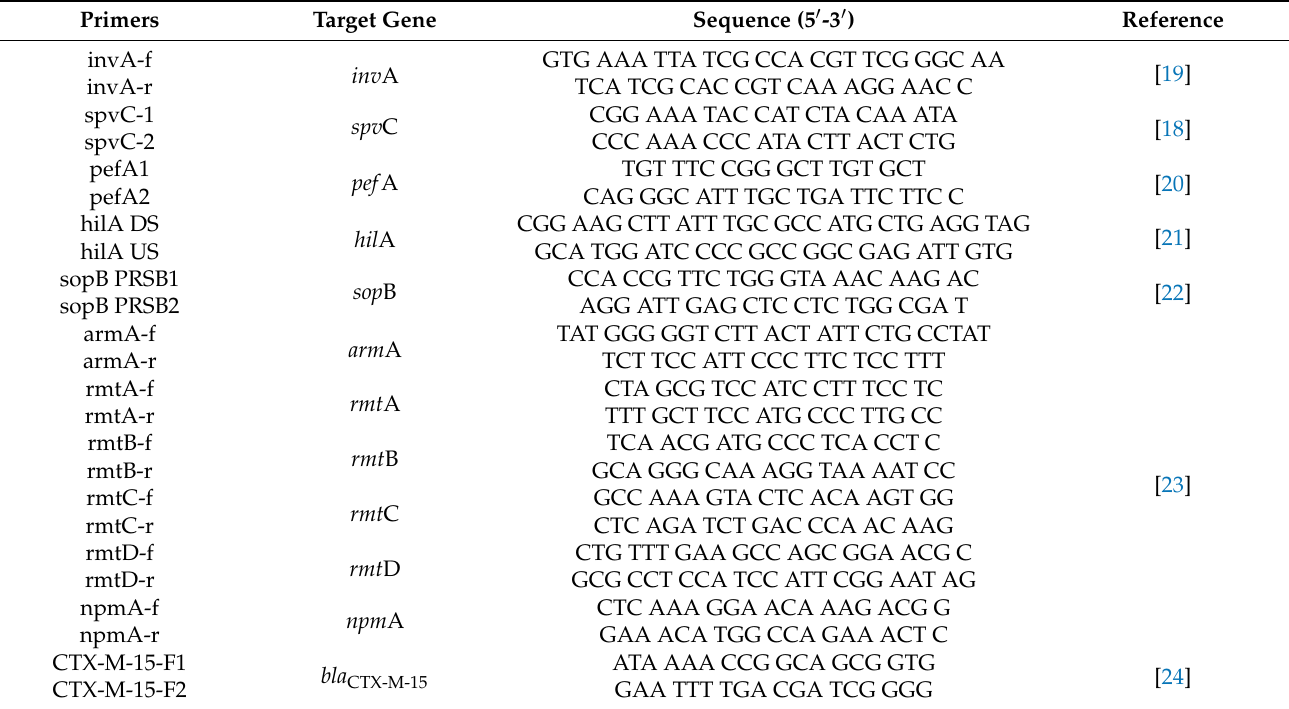
Table 1. List of primers for virulence and antimicrobial resistance genes. Primers Target Gene Sequence (5 (cid:48) -3 (cid:48) )